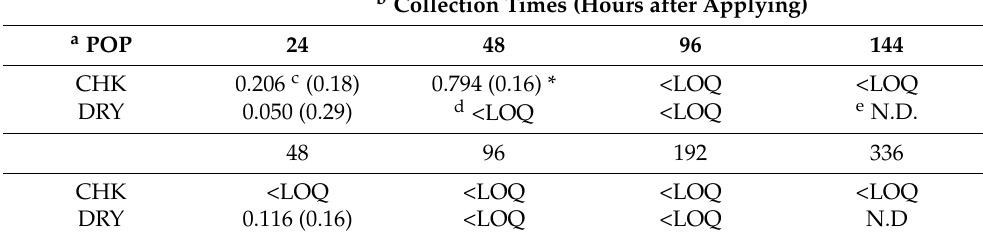
Table 3. Quizalofop-p concentration ( µ g g − 1 ) absorbed by Eragrostis plana populations (CHK and DRY) four times after applying quizalofop-p-ethyl, experiment 2 (24, 48, 96 and 144 h) and